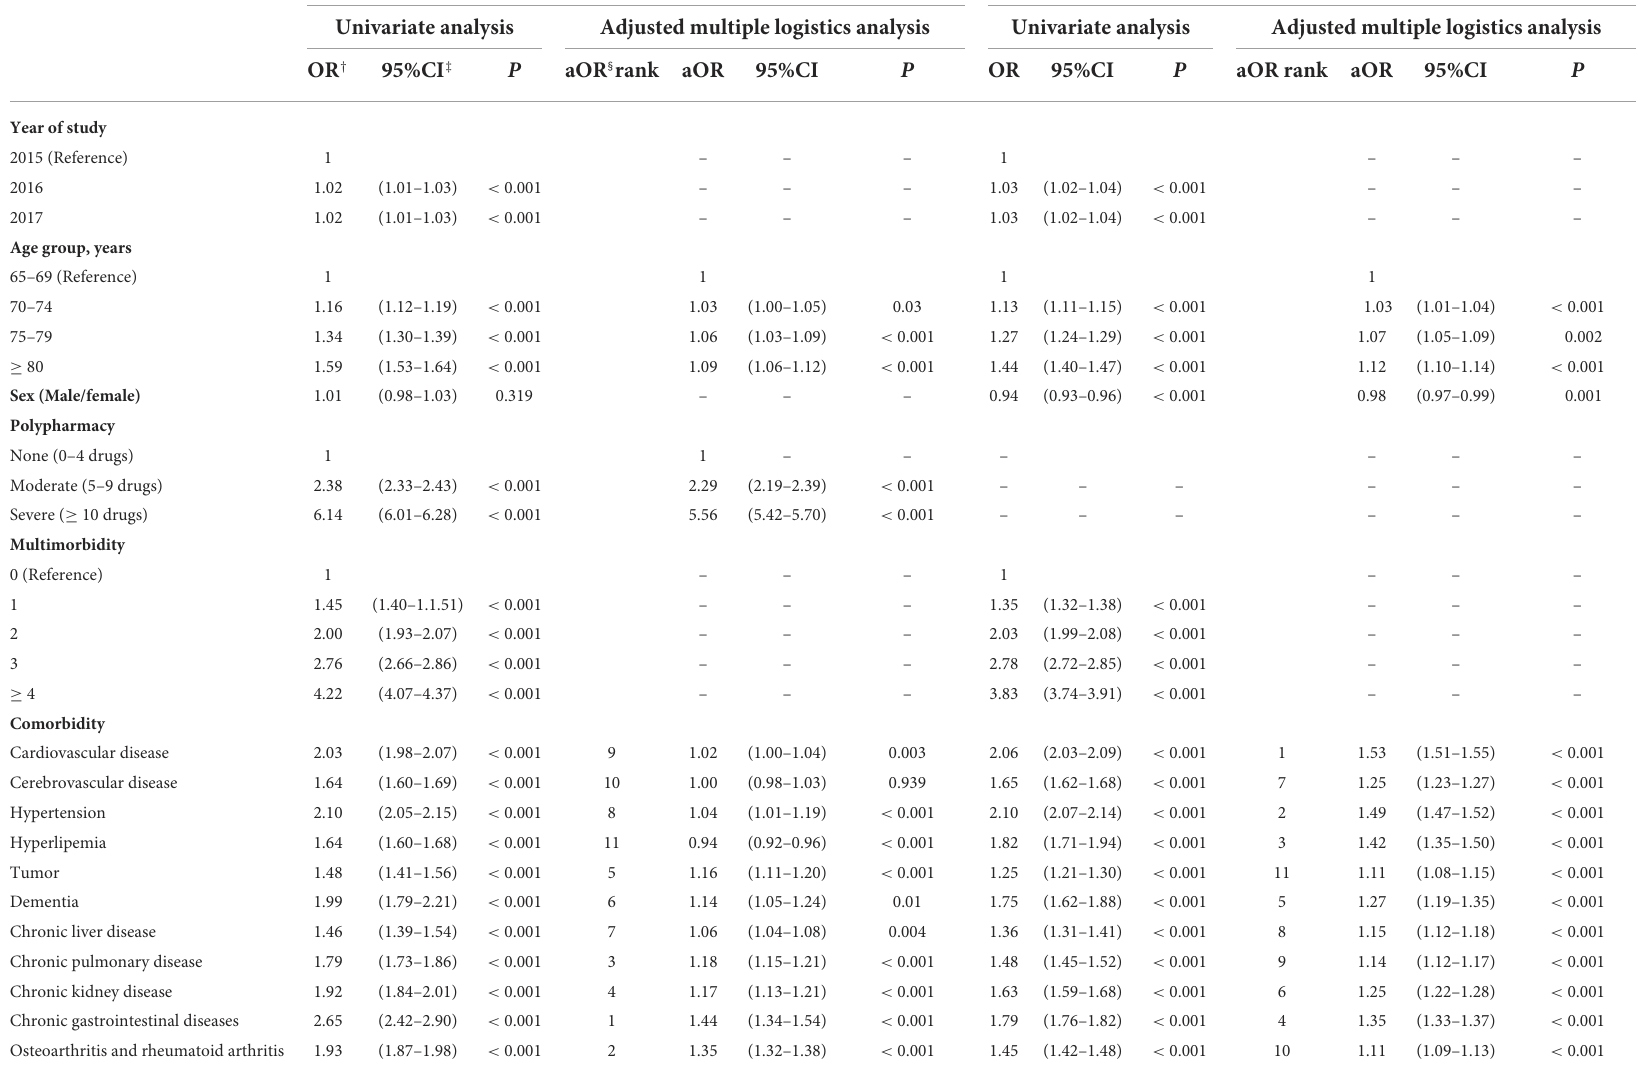
TABLE 2 Logistic regression analysis of factors associated with potentially inappropriate medications and